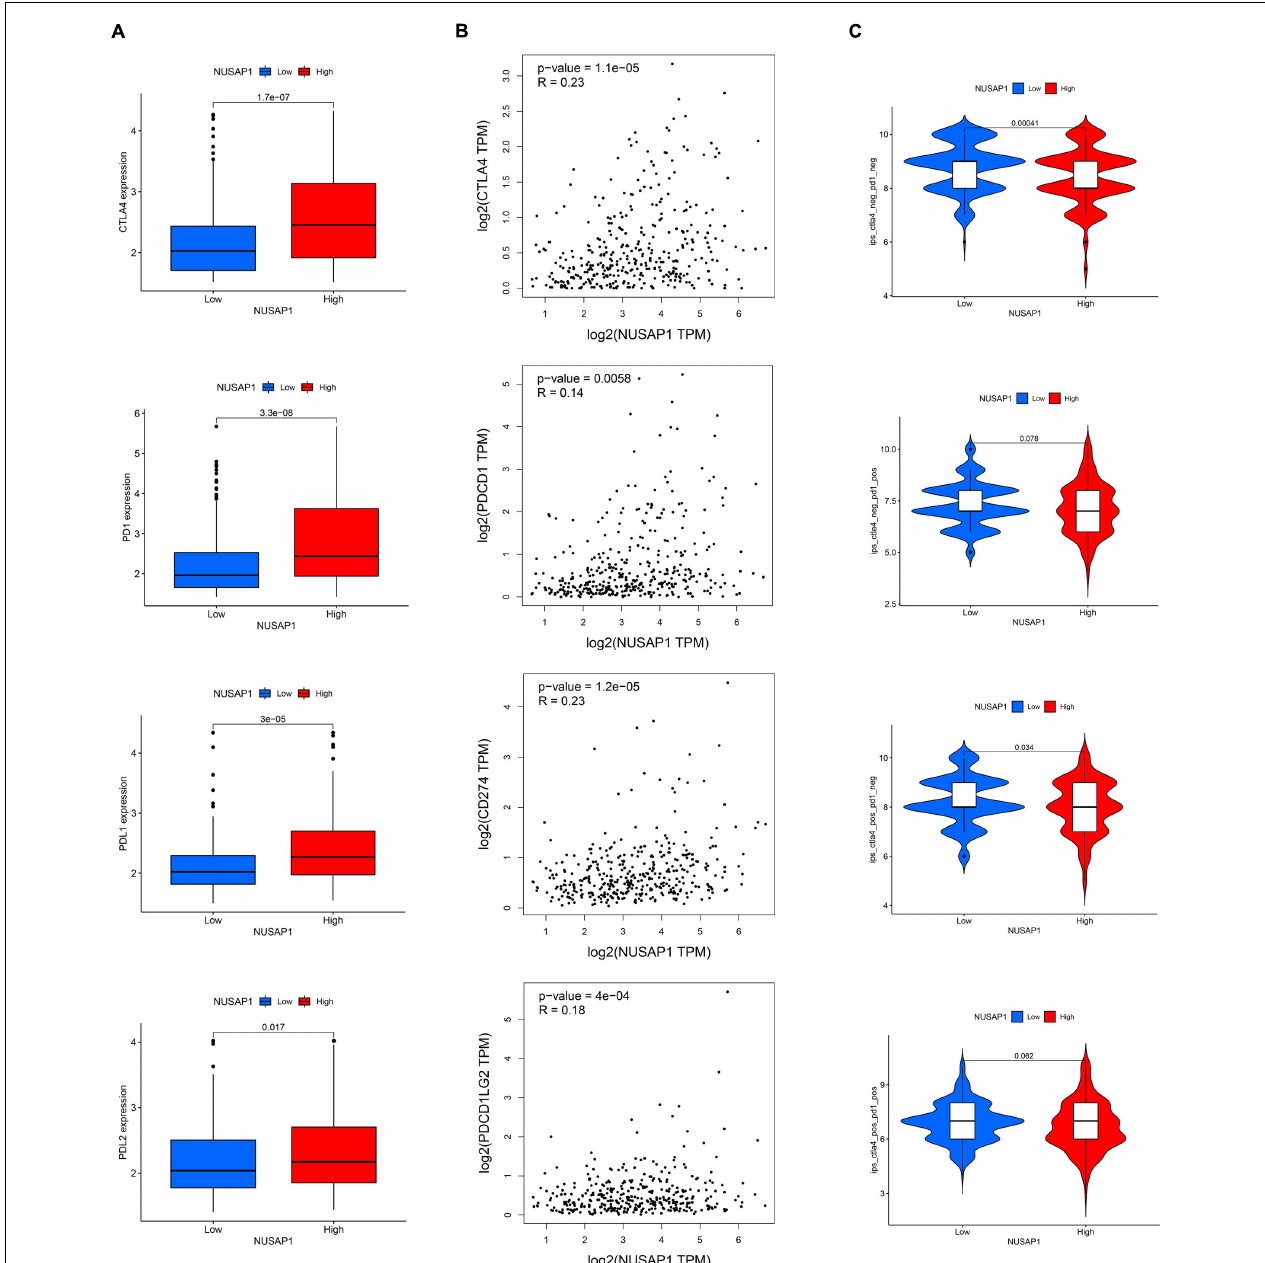
FIGURE 13 | The estimation of immunotherapy response between high and low expression group of NUSAP1. (A) The expression level of the four immune checkpoint molecules (CTLA4, PD1, PD-L1, and PD-L2) in high and low expression groups. (B) The Pearson correlation coefficient between NUSAP1 and the four immune checkpoint molecules. (C) The IPS in high and low expression